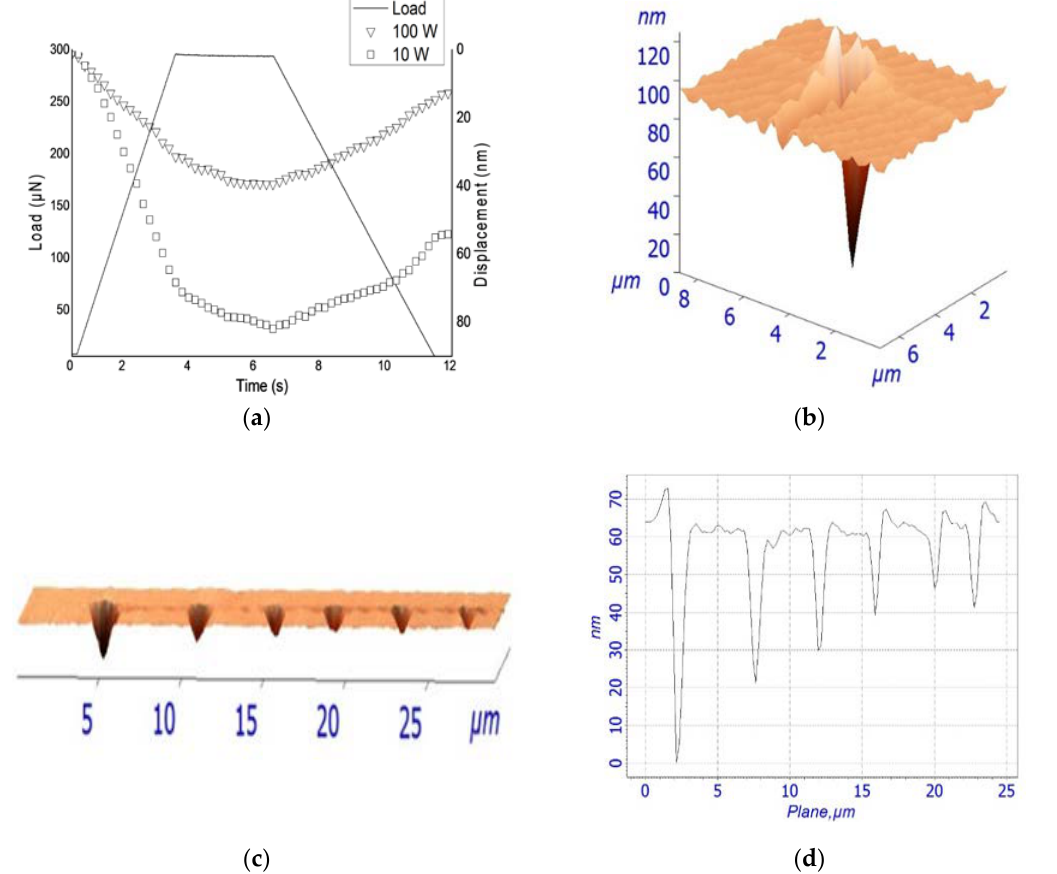
Figure 6. ( a ) Load displacement versus time curve of geranium oil-derived film fabricated at 10 W and 100 W. ( b ) Pile up and sink in phenomena in the film. ( c ) AFM image of plastic impressions left behind in geranium oil-derived thin polymer fabricated at 50 W after indentations. ( d ) Profile plane of the investigated surface. Table 4. Mechanical properties of geranium oil-derived thin polymer films fabricated at various power.